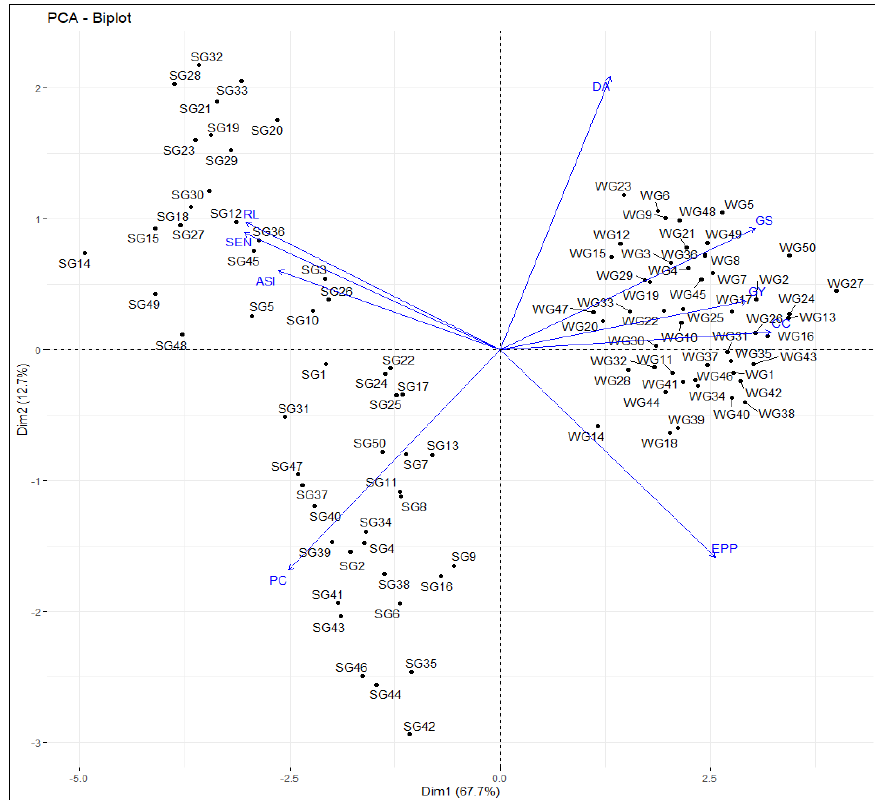
Figure 1. A combined principal component biplot showing genotypes clustering under stress and well-watered conditions. ASI—anthesis-silking interval, CC—chlorophyll content, DA—days to anthesis, EPP—ears per plant, GY—grain yield, Gs—stomatal conductance, RL—leaf rolling, SEN—leaf senescence, PC—proline content, SG—genotypes under water stress conditions, WG -genotypes grown under optimum conditions.